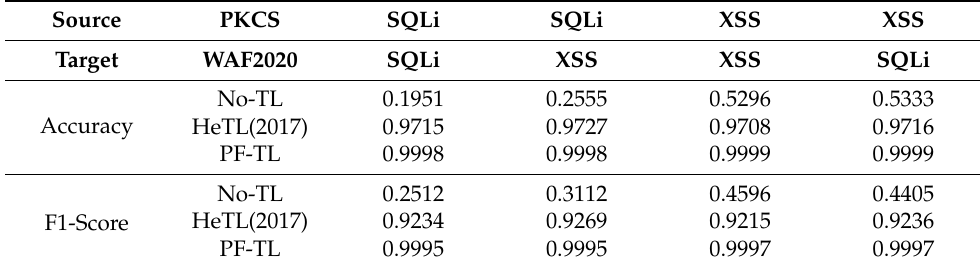
Table 11. Performance comparison of transfer learning on Scenario